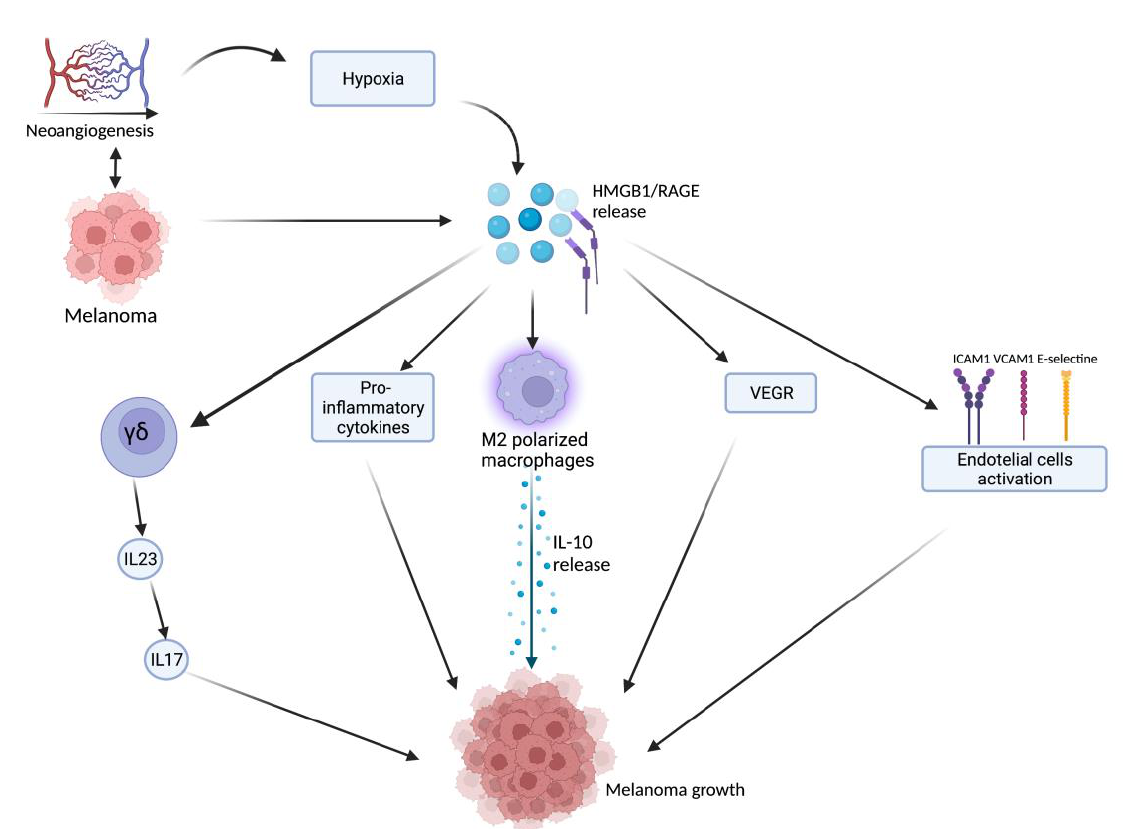
Figure 1. Tumor microenvironment and hypoxia, caused by cancer cells’ metabolic and oxygen demands, enhance HMGB1 release. HMGB1 binds to RAGE and actives several pathways: γδ -T cells, pro-inflammatory cytokines release, M2-macrophages, VEGF activation, and endothelial cell activation. All these lead to melanoma growth through the maintenance of an inflammatory microen- vironment. Created with